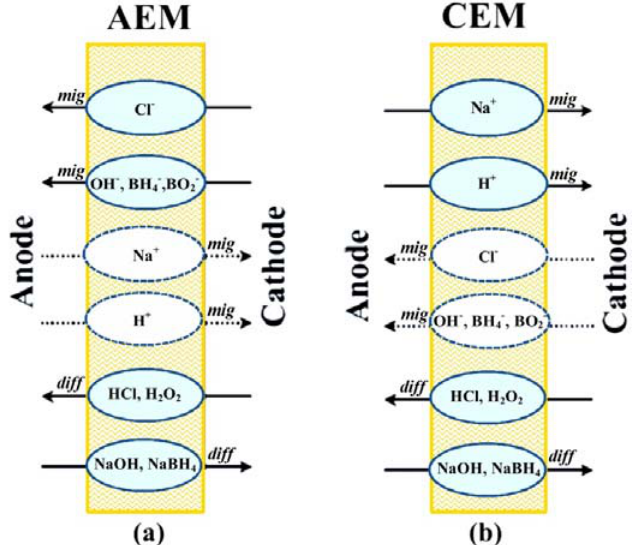
Figure 1. Schematic illustration of the major migrative and diffusive fluxes across ( a ) anion and ( b ) cation exchange membranes used in direct borohydride/peroxide fuel cells